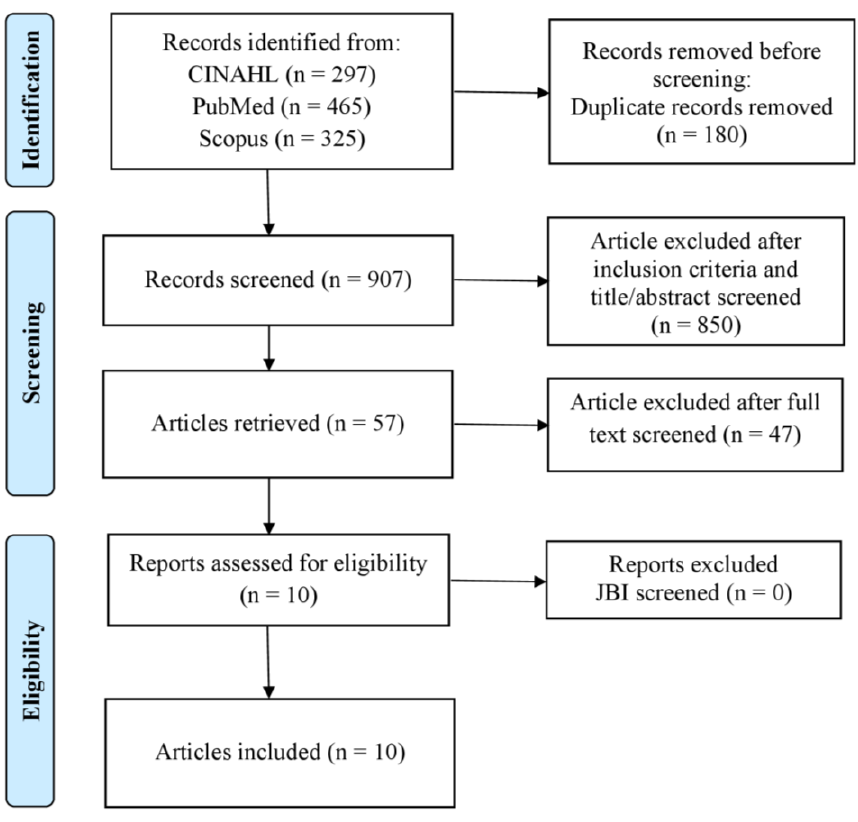
Figure 1. PRISMA flow diagram.